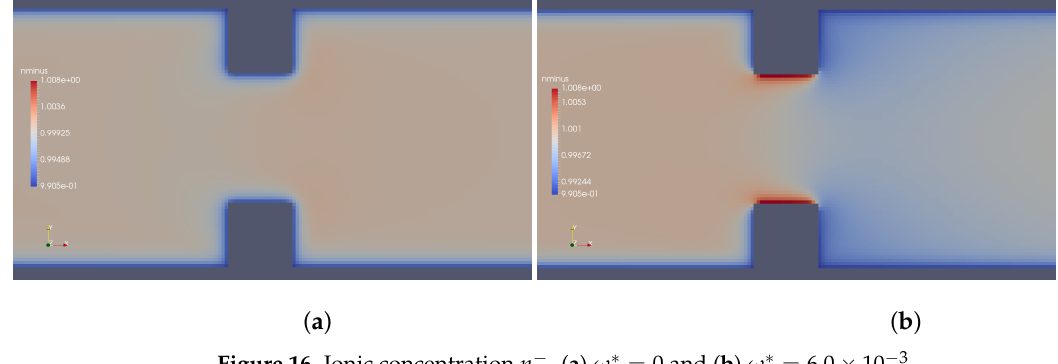
Figure 16. Ionic concentration n − . ( a ) ω ∗ = 0 and ( b ) ω ∗ = 6.0 × 10 − 3 .